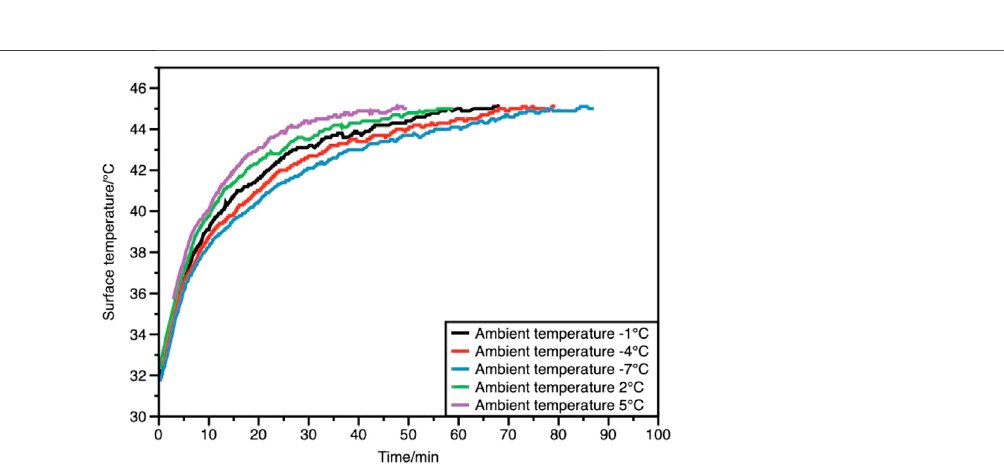
FIGURE 3 | Surface temperature of